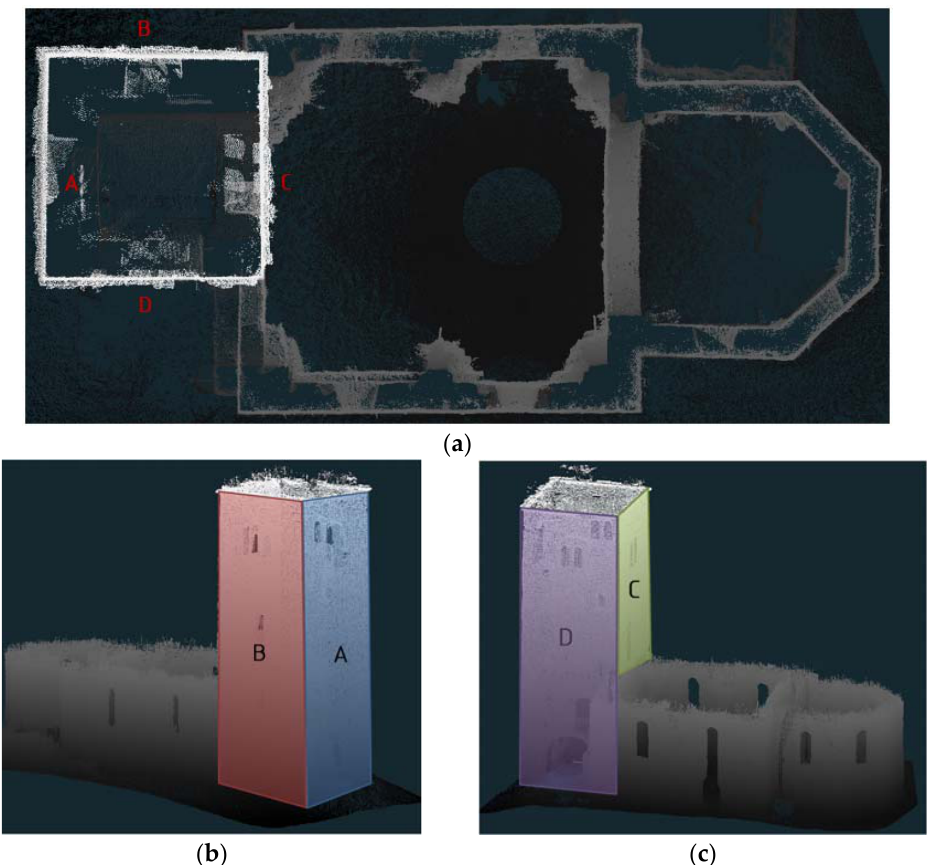
Figure 3. The observed walls represented by the planes A–D. ( a ) The orthographic top-down view; ( b ) and ( c ) are side views of the observed planes.